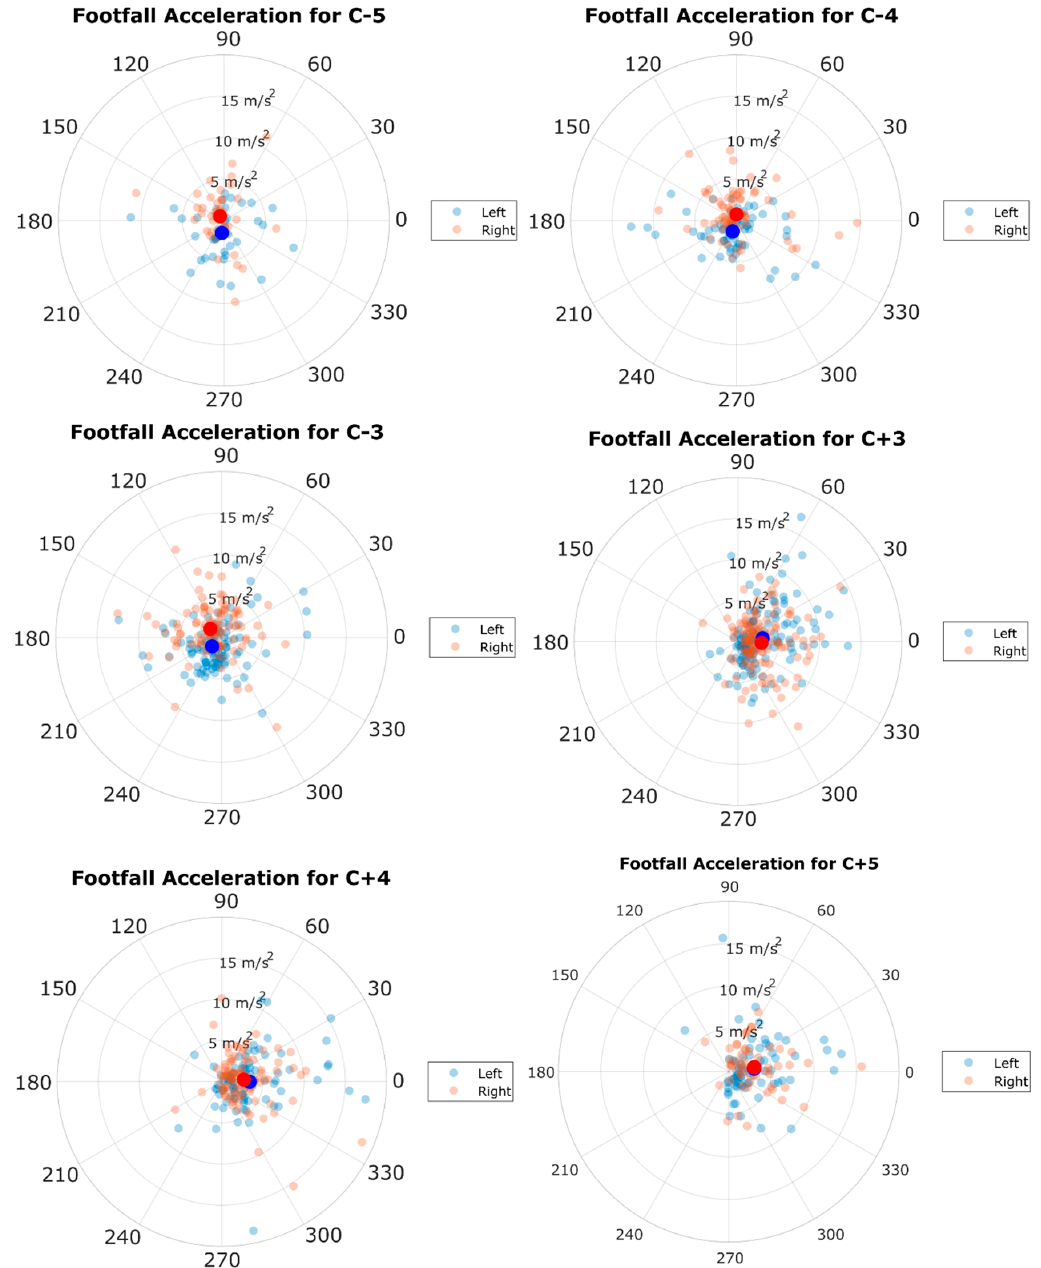
Figure A1. Footfall accelerations for each cutting footfall not featured in Figure 8. The zero-degree direction was defined as the player’s local forward axis ( + X); the 90 ◦ line ( + Y) is to the player’s left. The solid blue and red dots represent the mean left and right accelerations, respectively.